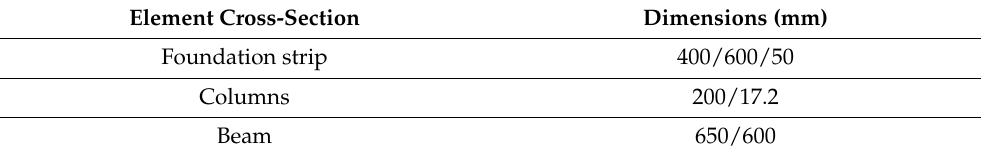
Table 3. Numerical model